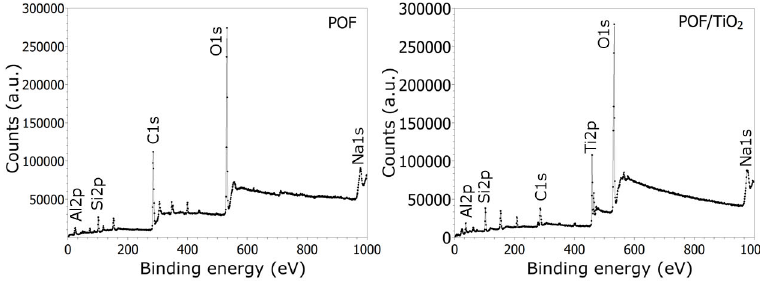
Figure 4. XPS survey scan for POF ( left ) and POF/TiO 2 ( right ).